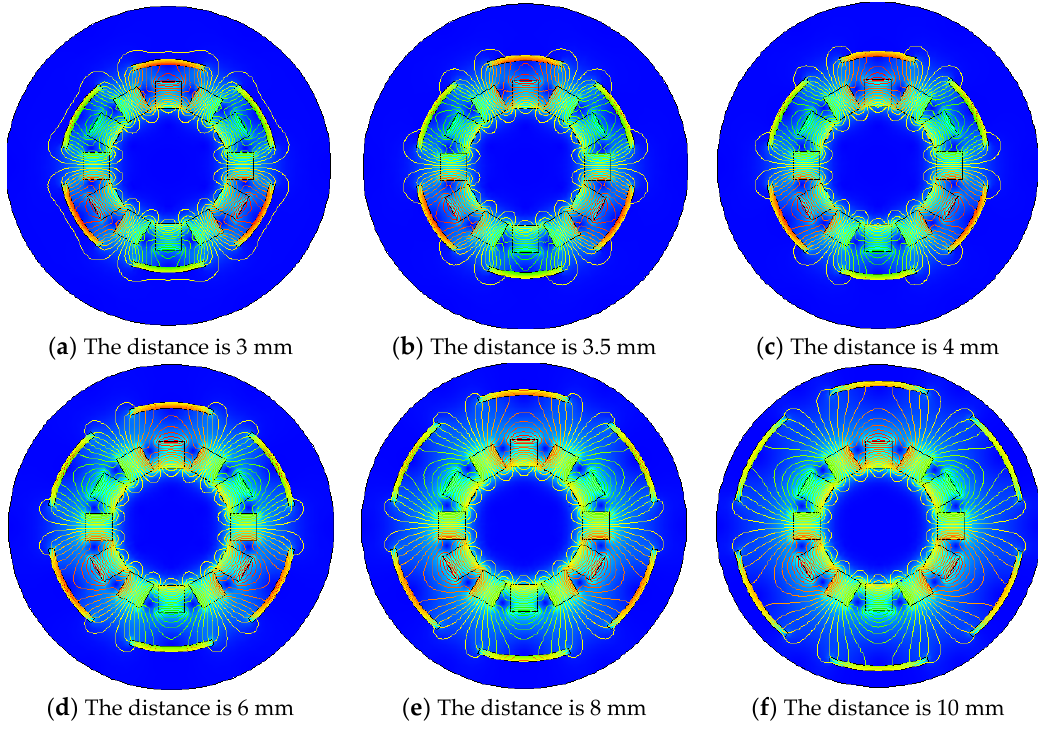
Figure 10. Magnetic field distribution of iron sheet and Halbach array at different distances.